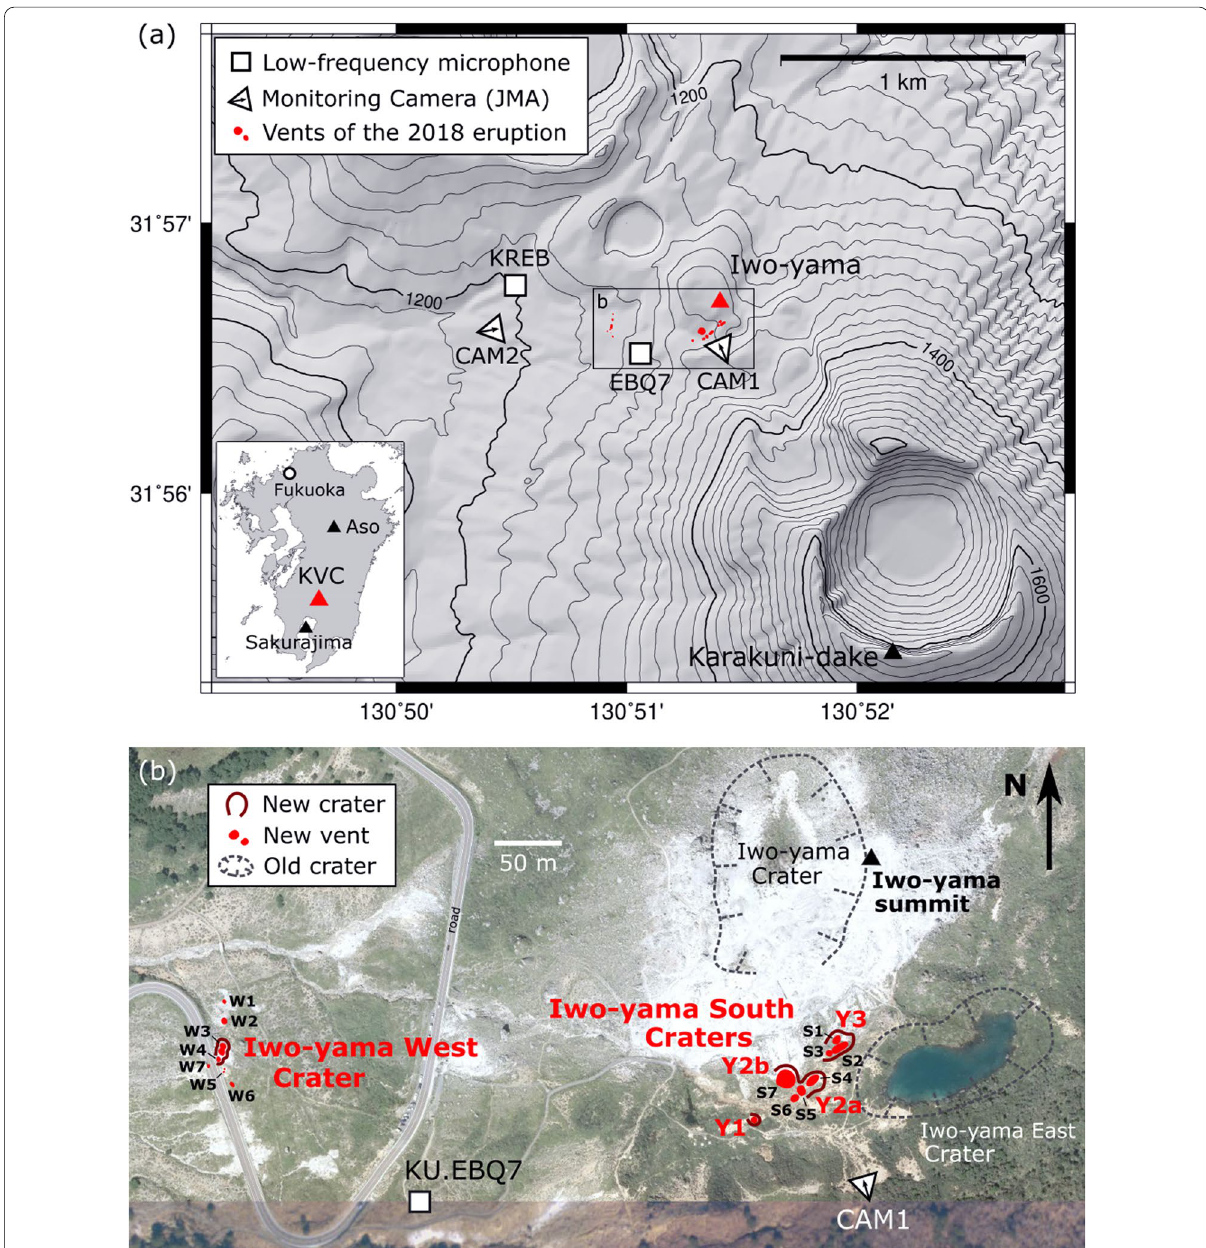
Fig. 1 Observation sites and crater locations. a Iwo-yama volcano (summit is indicated by the red triangle) and the locations of the observation sites. The contour interval is 20 m. The small red circles are the vents of the 2018 small phreatic eruption. The region surrounded by the rectangle is enlarged in b . Map inset shows the location of Kirishima Volcanic Complex (KVC) on Kyushu Island, southwest of Japan. b Craters and vents of the 2018 eruption. Their locations and naming were cited from Tajima et al. (2020). The photograph was taken from GSI Tiles, of the Geospatial Information Authority of Japan. There are two newly formed main craters, Iwo-yama South Craters (the South Crater) and Iwo-yama West Crater (the West Crater). The craters were composed of several vents, namely S1 to S7 in the South Crater and W1 to W7 in the West Crater. After the onset of the eruption, the vents in the South Crater merged into three sub-craters (Y2a, Y2b, and Y3); the vents S1–S3 to Y3, S4–S6 to Y2a, and S7 to Y2b. In this study, we call the sub-craters as vents because our analysis does not have a resolution to discriminate the individual vents in the South Crater (S1–S7). Y1 appeared on April 7, 12 days before the eruption. We excluded it from the discussion because it did not participate in the